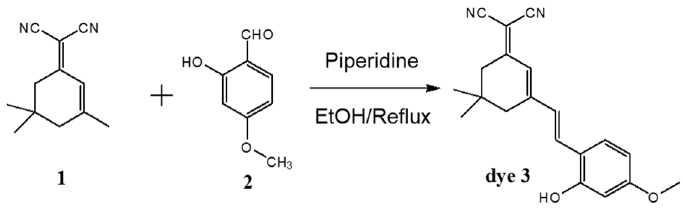
Figure 2. The synthetic route for dye 3.